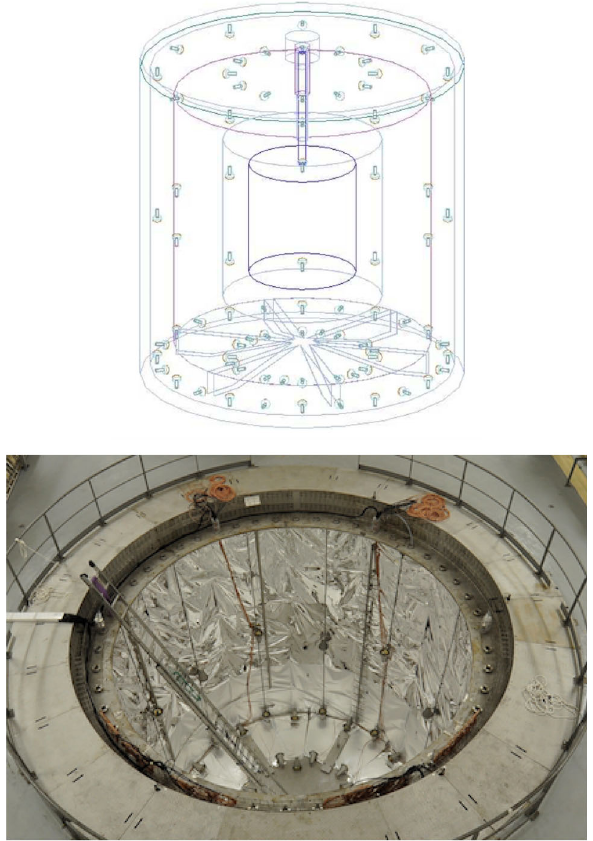
Fig. 4 SchematicviewofthePMTlayoutintheinnervetos(top).There were 78 PMTs arranged in five rings with alternating orientations along the rings. The open near detector veto vessel with the inner surface covered by the VM2000 reflective foil is shown at